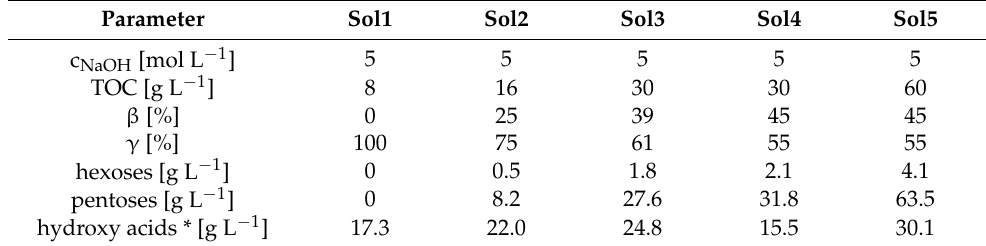
Table 1. Composition of the used five streams.